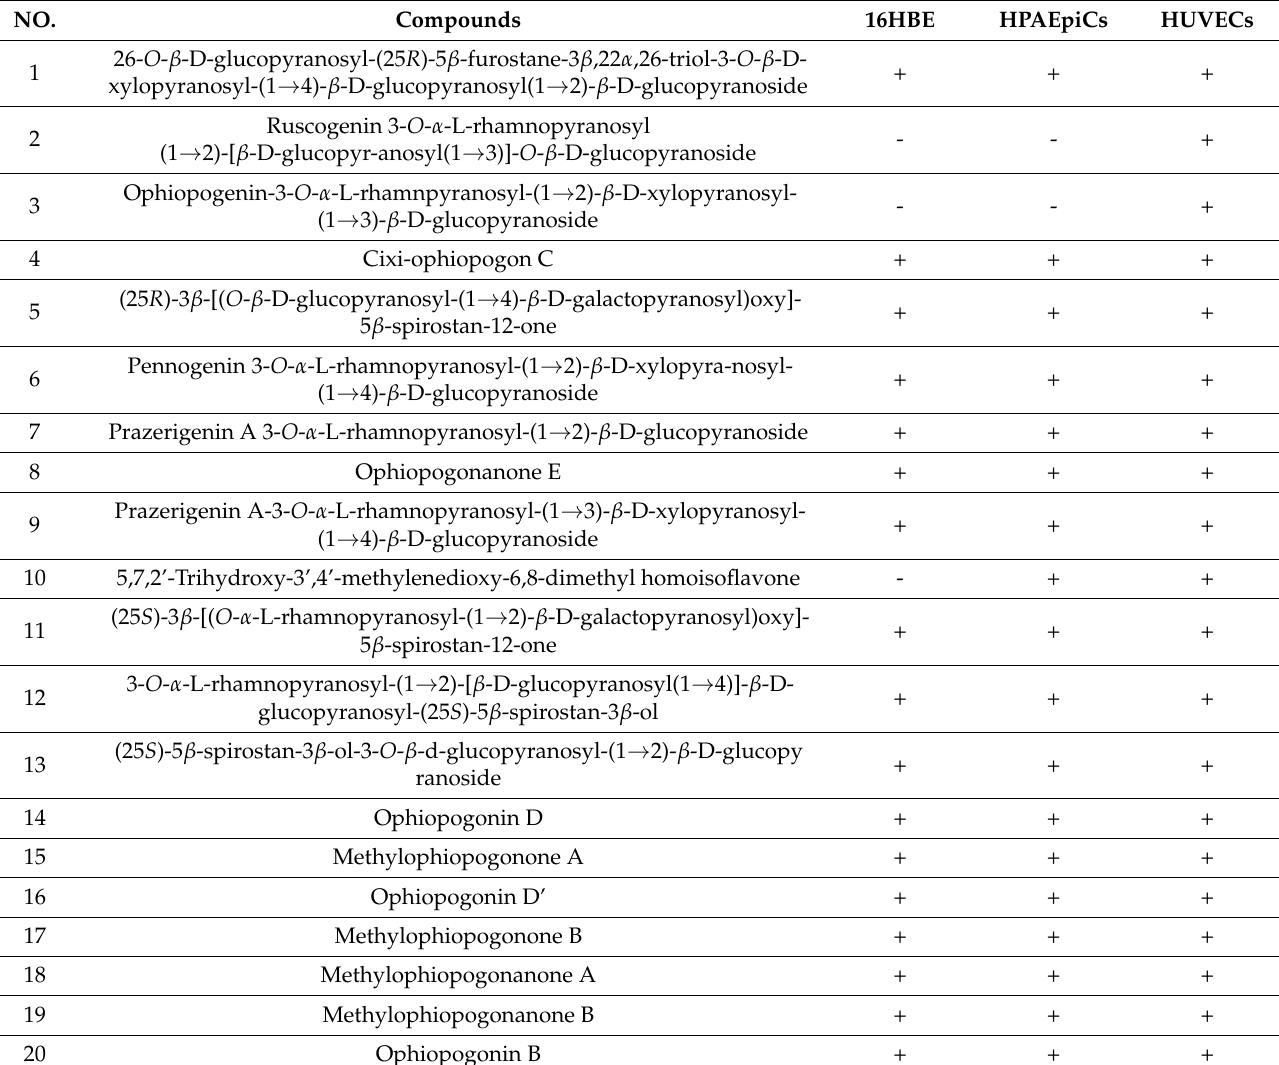
Table 1. The compounds that bound to 16HBE, HPAEpiCs or